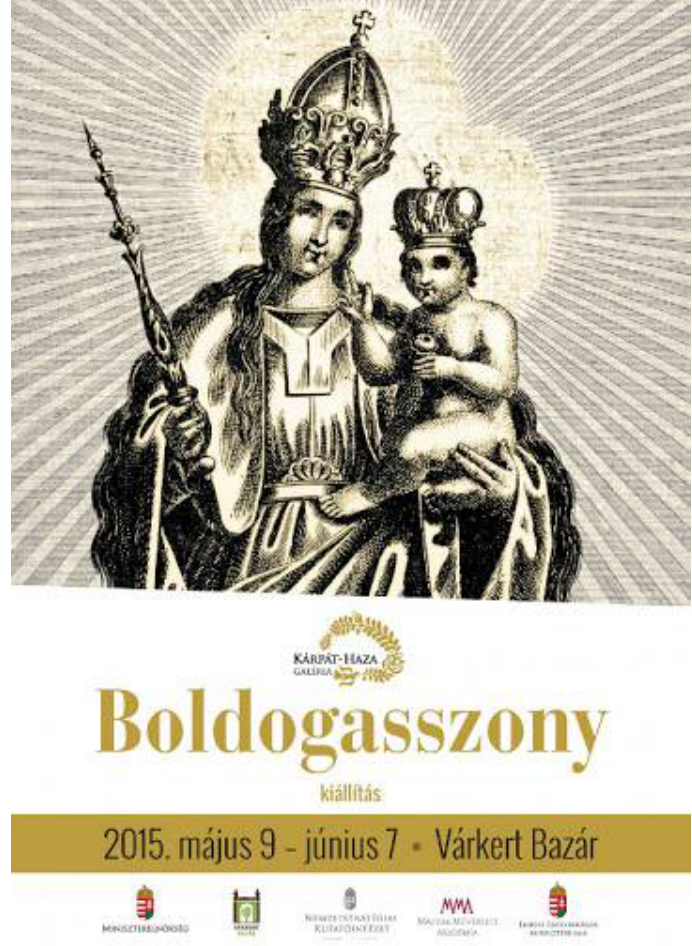
Figure 9. Invitation to the Exhibition at the Varkert Bazar.